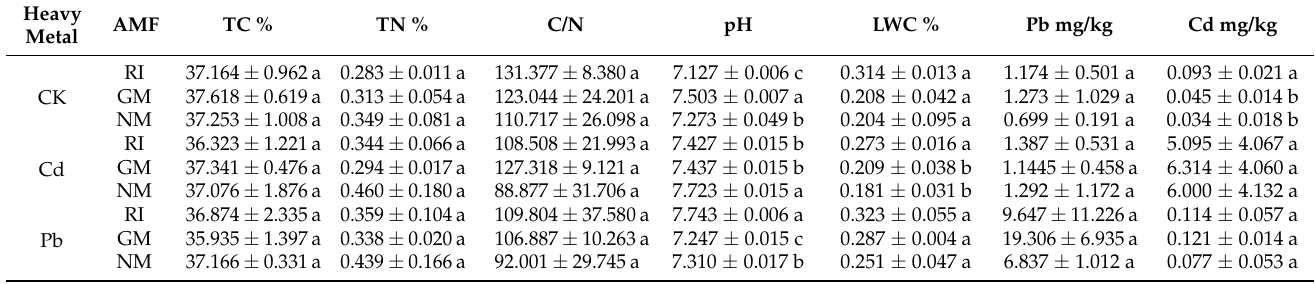
Table 2. Influence of AM fungi infection on the properties of litter under heavy metal stress.